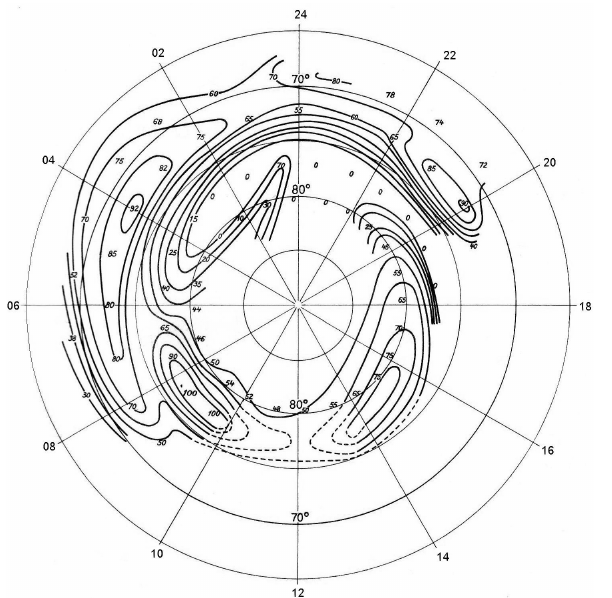
Figure 6. Auroral frequency pattern for the IQDs of 1957–1958. Isoauroral lines are drawn on the polar graph with magnetic latitude and local time (Lassen, 1963). Dashed lines illustrate interpolated isoauroral lines due to missing data during daytime